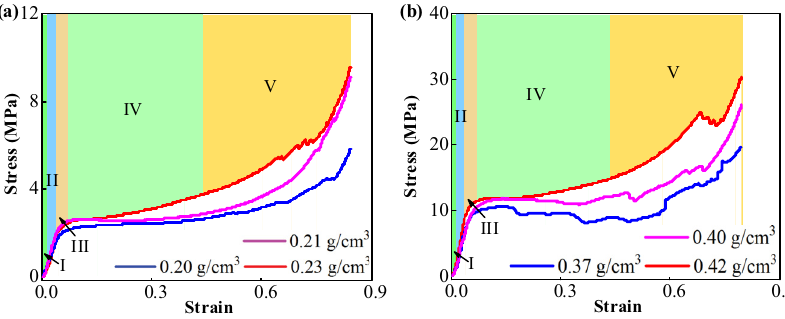
Figure 5: The representative stress – strain curves of the TFPU grouting materials with two di ff erent densities: ( a ) 0.2 ± 0.03 g · cm − 3 and ( b ) 0.4 ± 0.03 g · cm − 3 . The stress and strain de fi ned are nominal stress and engineering strain,